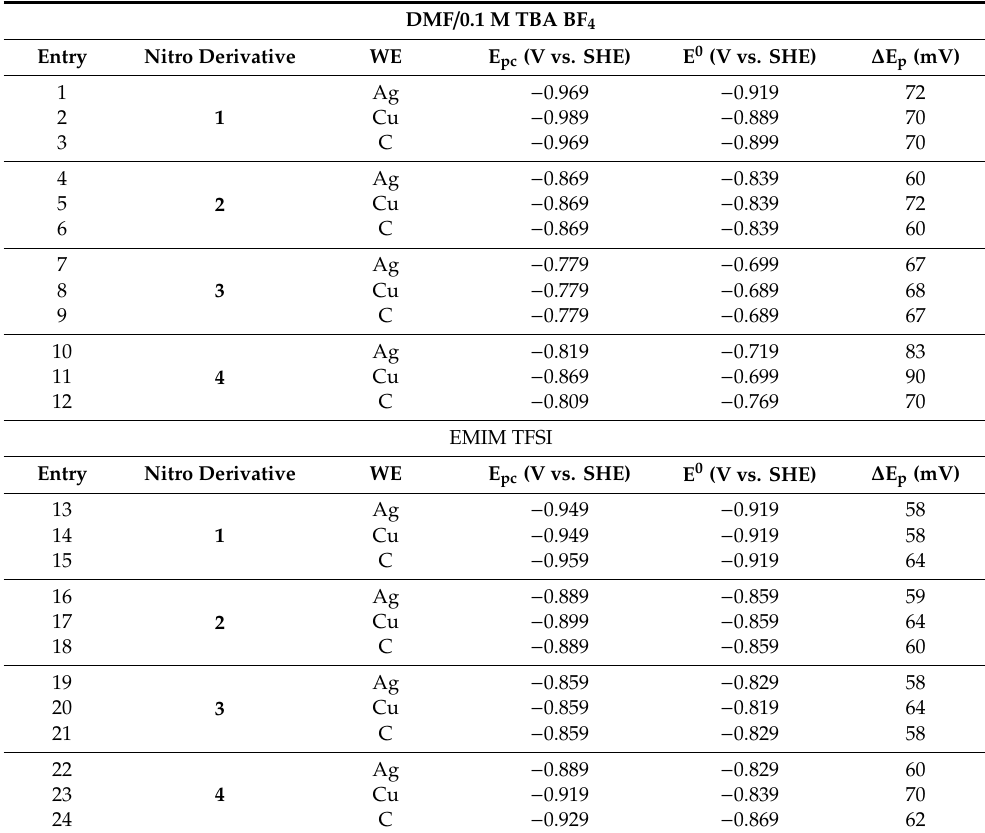
Figure 2. Cyclic voltammetry of 10 mM p -nitro compounds 1 - 4 with Ag (black line), Cu (red line) and Table 1. Standard potential (E ◦ ), cathodic peak potential (in V vs. SCE, Epc) and peak witdh ( ∆ Ep C (blue line), under nitrogen atmosphere. Scan rate: 0.5 V·s −1 . Solution of DMF/0.1M TBA BF 4 (left) (mV)) for 1 - 4 in di ff erent solvents using di ff erent working electrodes (WE) at 20 ◦ C. and solution of 3 mL EMIM TFSI (right). Table 1. Standard potential (Eº), cathodic peak potential (in V vs. SCE, Epc) and peak witdh (ΔEp (mV)) for 1 - 4 in different solvents using different working electrodes (WE) at 20